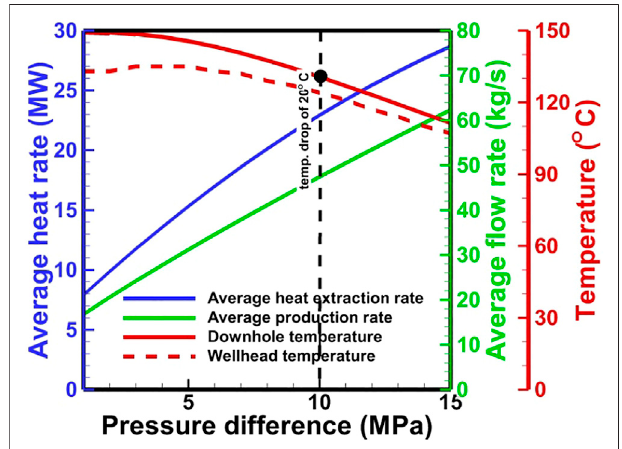
FIGURE 12 | Effect of pressure difference on performance for the H 2 O-based